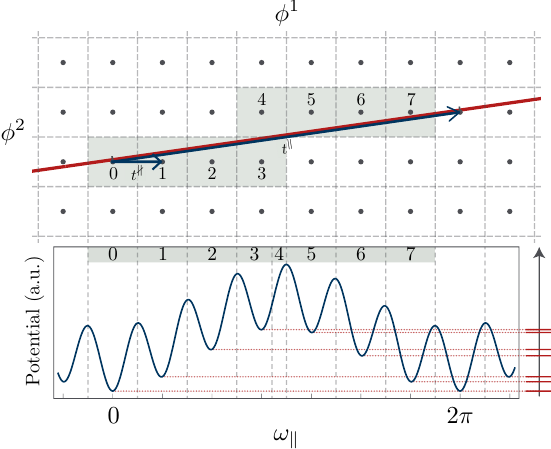
Figure 1 . Top : constraint surface (red line) along with the lattice 2 (cid:25) Z P (gray dots). Arrows show the aligned basis vectors t k and t , . Bottom : axion potential as a function of the aligned coordinate ! (de(cid:12)ned later in (2.18)). Distinct tiles k